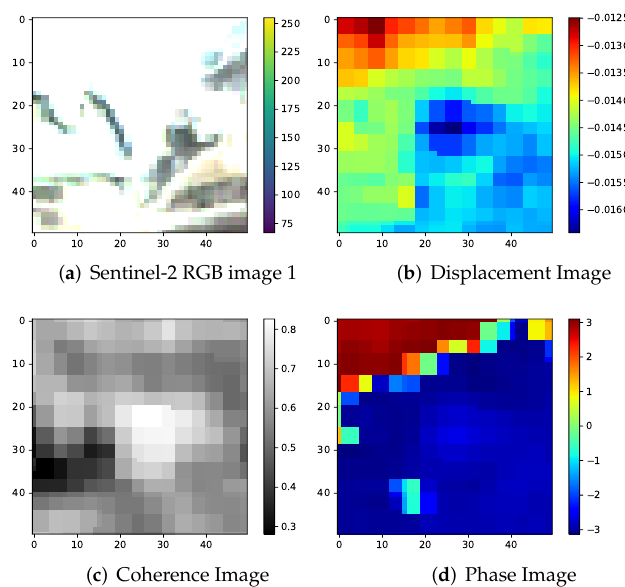
Figure 14. True-positive blob of a tailings mine dump retreatment